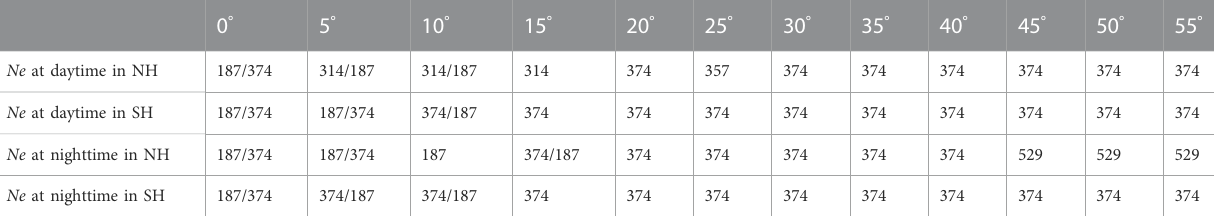
TABLE 1 Chromatography